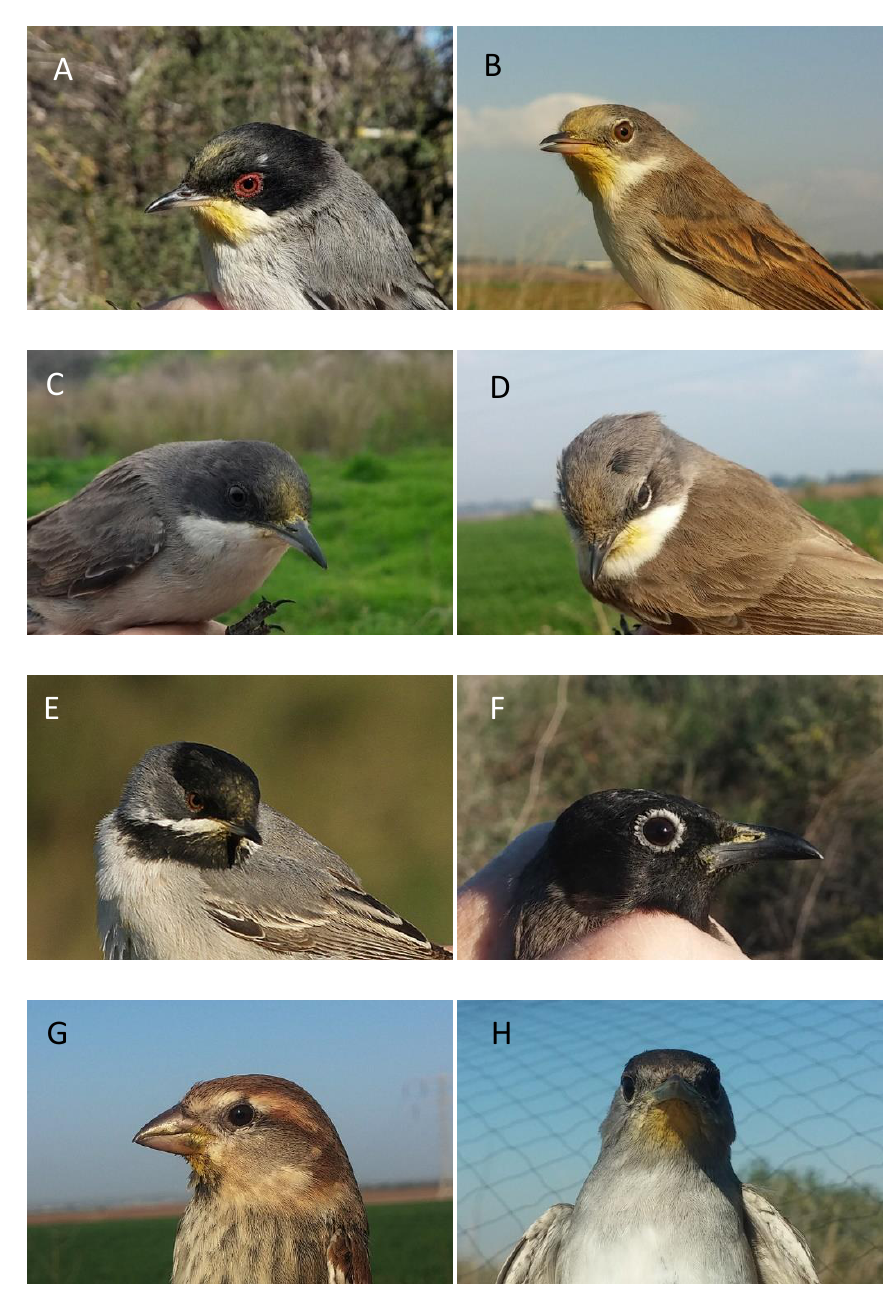
F IGURE 3. Pollen of A. foetida on feathers of (A) Sylvia melanocephala, (B) Sylvia communis, (C) Sylvia crassirostris, (D) Sylvia curruca, (E) Sylvia rueppelli, (F) Pycnonotus xathophygos, (G) Passer hispaniolensis, (H) Sylvia